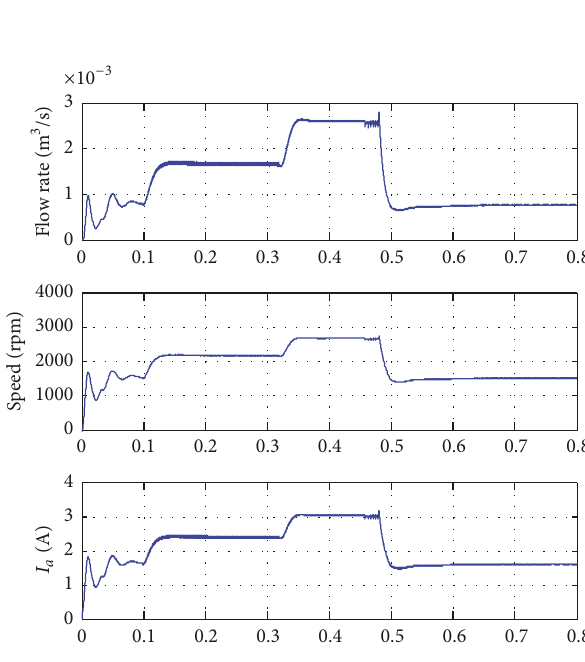
Figure 17: Flow rate, PMDC motor rotor speed, and armature current at various solar irradiation values.